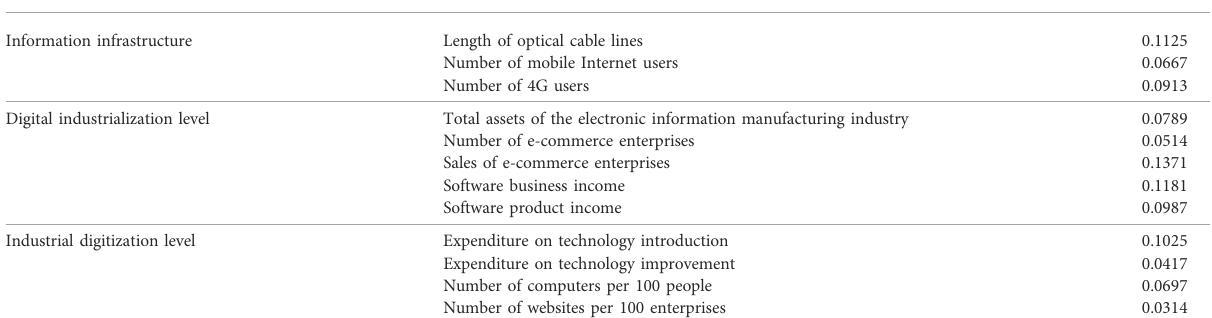
TABLE 1 Digital economy index